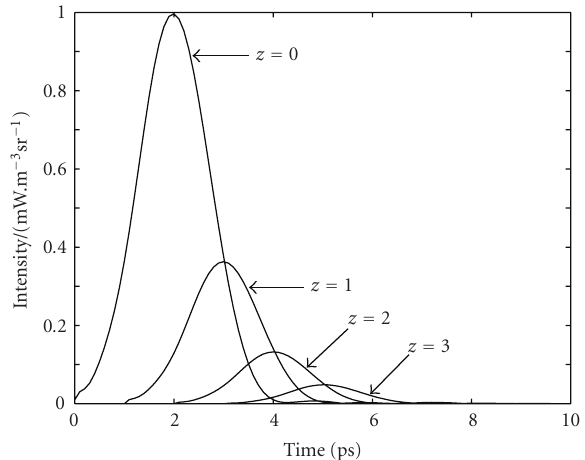
Figure 5: Forward intensity at di ff erent locations for isotropic ( g = 0)